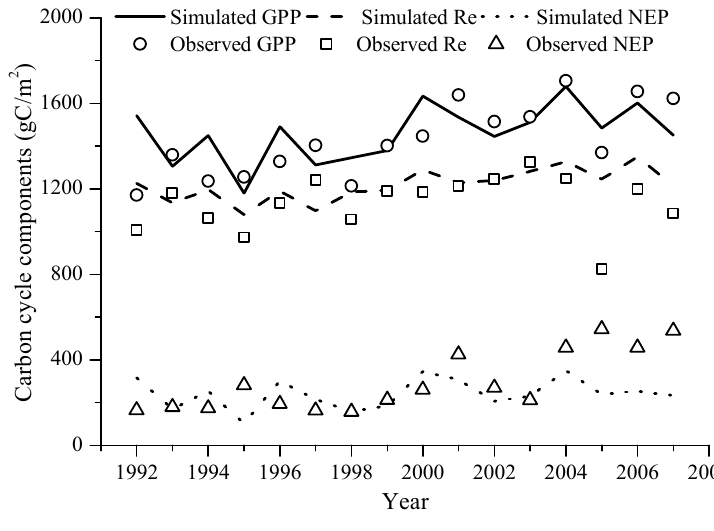
Figure 2. Simulated and observed annual GPP (RMSD = 148.3 g C m − 2 ), Re (RMSD = 137.3 g C m − 2 ) and NEP (RMSD = 157.7 g C m − 2 ). Observation is aggregated from the hourly gap-filled eddy covariance measurements. Simulated GPP was computed within the vegetation dynamics module of Agro-IBIS; Re was computed within both the vegetation dynamics module and belowground carbon cycling module of Agro-IBIS, NEP was computed as the difference between GPP and